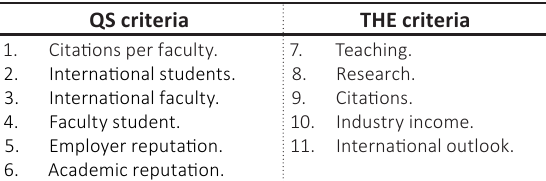
Table 1. List of criteria for calculating QS and THE, whose numerical values are combined in an OPT QS criteria THE